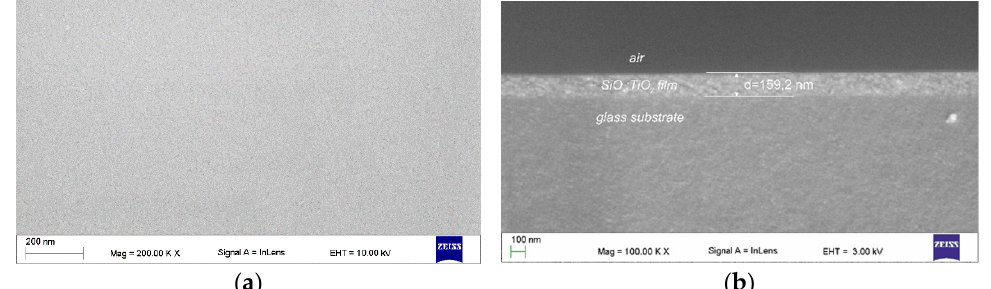
Figure 9. SEM images of top ( a ) and cross section ( b ) of the slab waveguide structure.